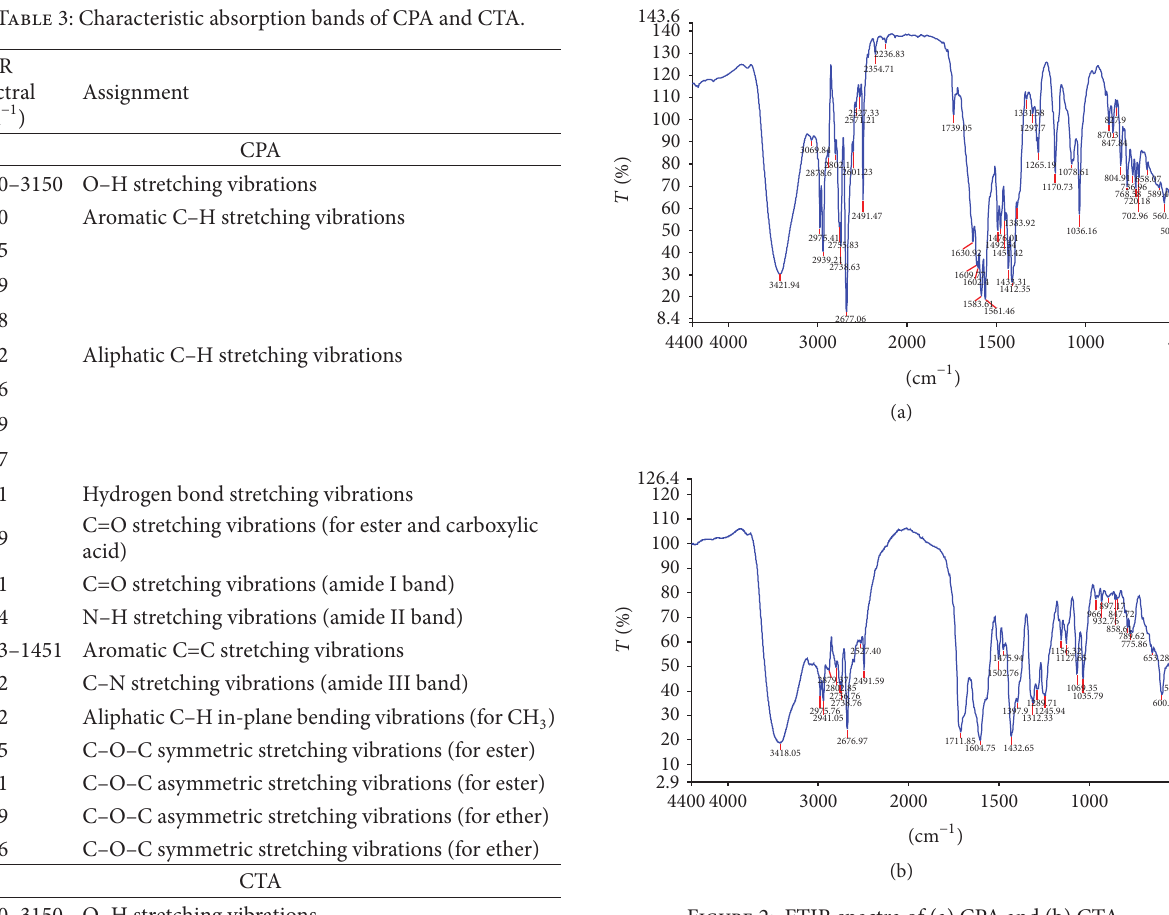
F 2: FTIR spectra of (a) CPA and (b)